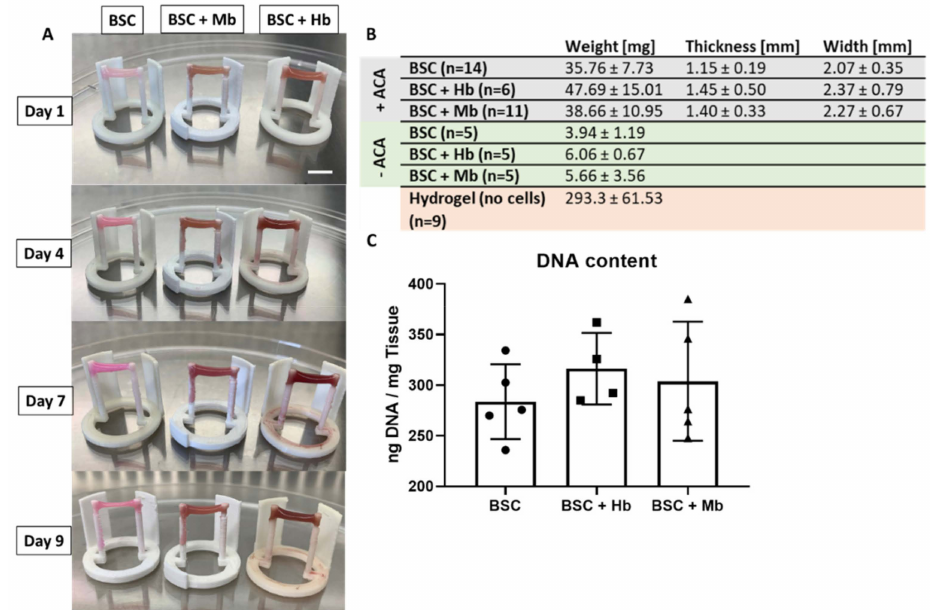
Figure 3. Properties of skeletal muscle tissue formation. ( A ) Representative images of bioartificial muscles (BAMs) generated from BSCs, BSCs + Hb, and BSCs + Mb (3 mg / mL for both heme proteins) at di ff erent time points (one, four, seven, and nine days of incubation), showing increased color intensity in constructs with Hb and Mb. Scale bar is 10 mm. ( B ) Weight, width, and thickness of BAMs at time point of harvest are presented. Groups were compared against groups without added ACA (–ACA) and fibrin gel without added cells, both incubated for an equal amount of time, in the same conditions, for comparison of hydrogel compaction by the cells. Width and thickness could only be measured in the + ACA BAMs, as –ACA BAMs detached from anchor points and lost their physical form. ( C ) DNA of BSCs, BSCs + Mb ( n = 5), and BSCs + Hb ( n = 4) was extracted by proteinase K degradation, and absorbance was measured with